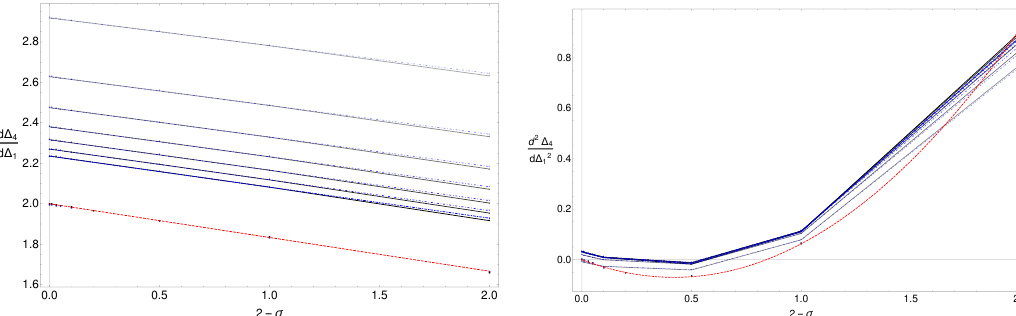
Figure 3 . First and second derivative of ∆ 4 at the free theory point, as a function of 2 − σ . The φ 4 curve, or the SG theory at fixed ξ , in red coincide to high precision with the large Λ extrapolation of the spectrum extraction from OPE maximization points in blue and the black gap maximization points. Both numerical approaches give very similar results. Note that the second derivatives, as estimated from finite differences, are not monotonic in the cutoff Λ